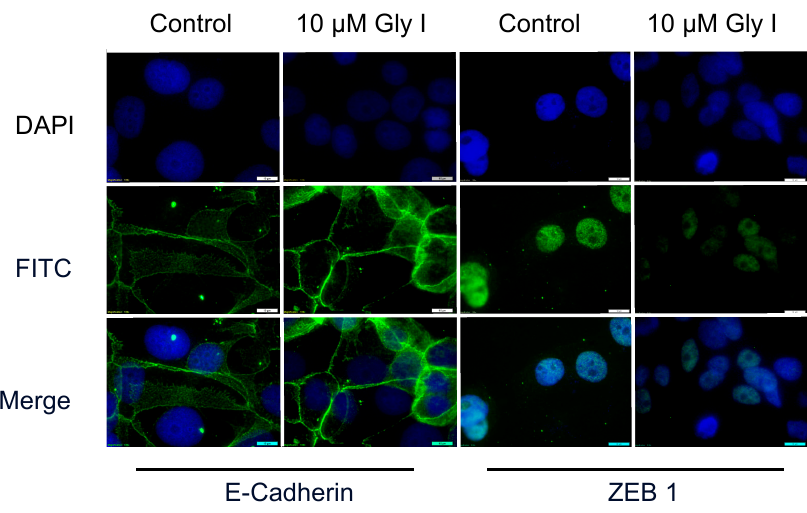
Figure 4. Glyceollin I Induces E-cadherin Protein Expression. Representative immunofluorescence images of LTLT-Ca cells treated with control (DMSO) or 10 µ M Glyceollin I for 24 h. Upper panels represent DAPI (blue) nuclear stained control and treated cells; middle panel represents anti-E-cadherin (green) FITC epithelial stained control and treated cells or ZEB1 (green) nuclear stain; bottom panel represents merged images of control and treated LTLT-Ca cells. Original magnification, 100X.